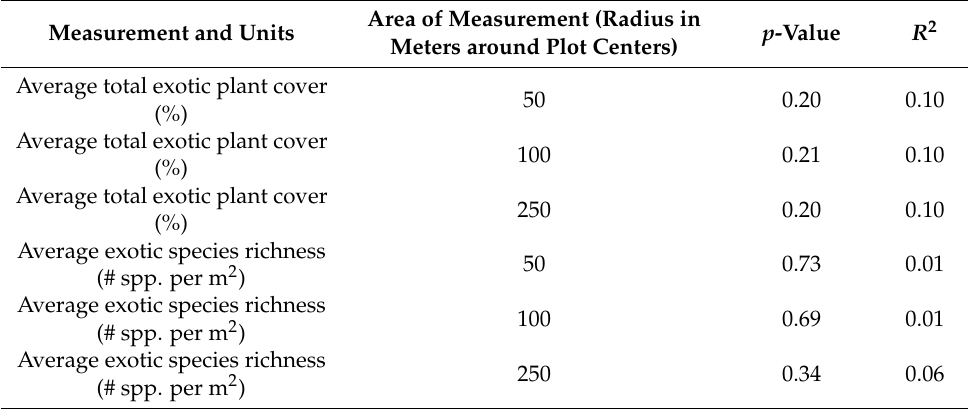
Table A4. R 2 and p -values for pre-disturbance mean total exotic plant cover (%) and species richness (# spp. per m 2 ) compared to amount of linear edge habitat from roads (m) within 50 m, 100 m, and 250 m of plot centers.